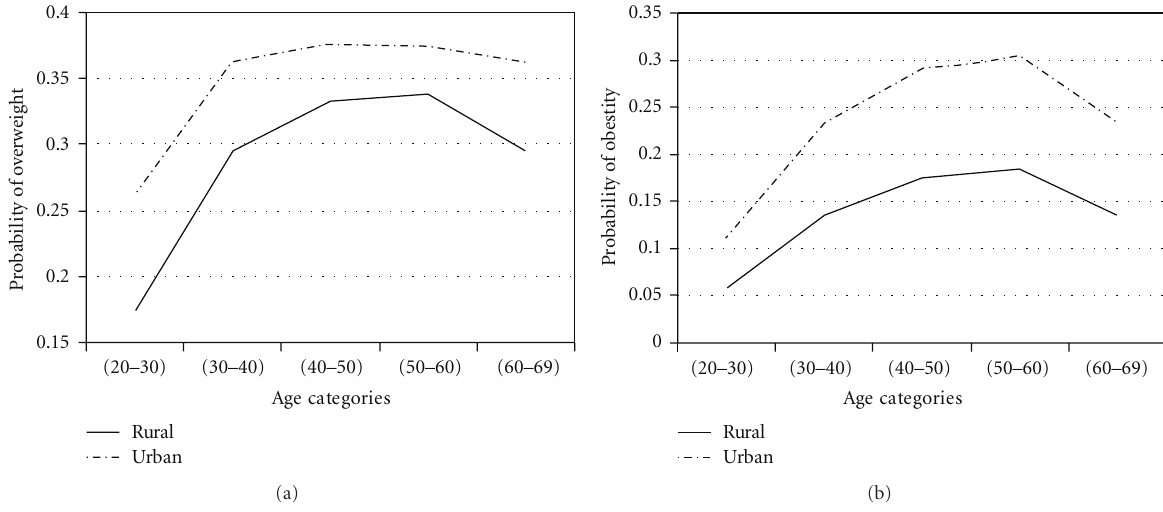
Figure 3: Probabilities of overweight and obesity across age groups for place of residence.